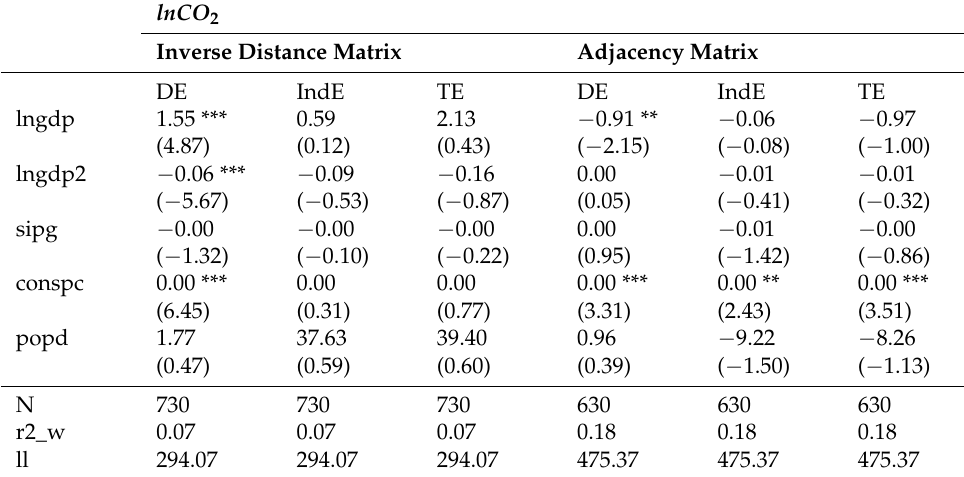
Table 7. The direct/indirect effects of robustness test.